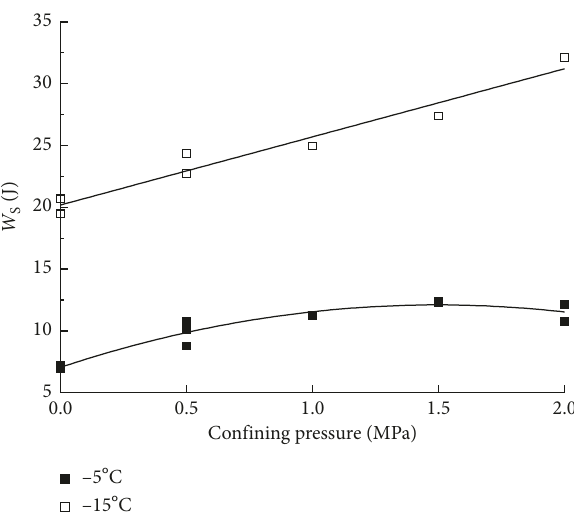
Figure 6: Absorbed energy of Group B under different test conditions.